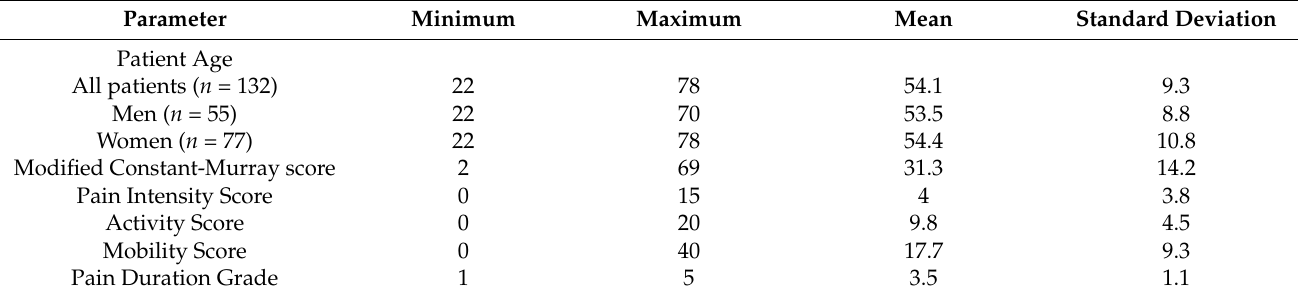
Table 1. Summary of patients’ ages and clinical impairment items.